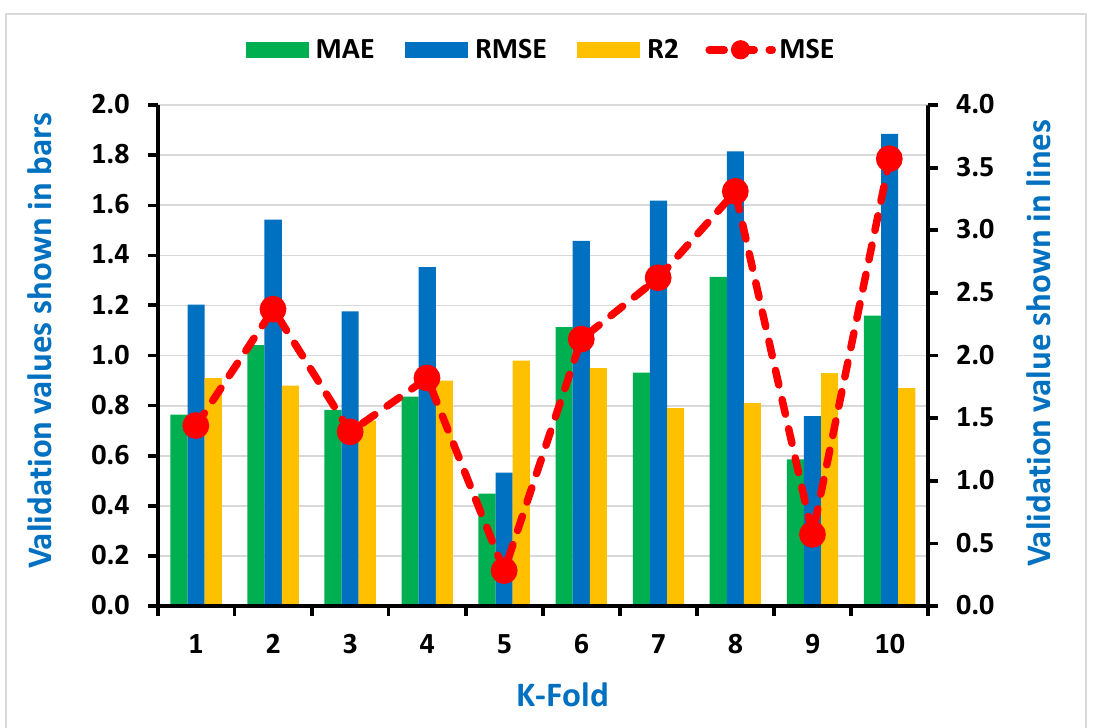
Figure 9. Representation of statistical information of k-fold cross-validation using AdaBoost for Compressive strength.